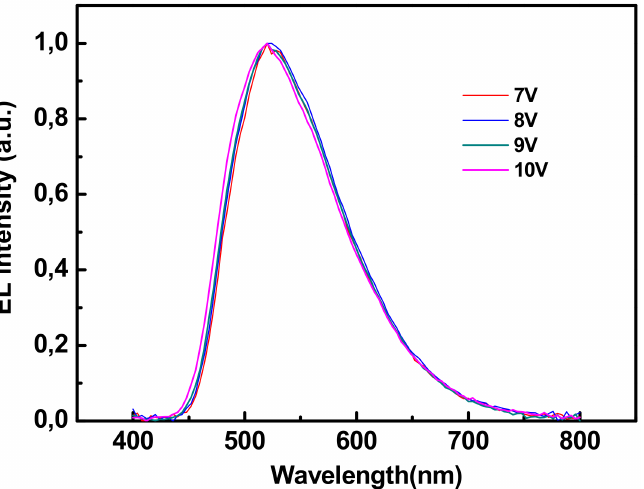
Figure 3. Electroluminescent spectra of the device indium tin oxide (ITO)/9/Alq 3 /LiF/Al at different